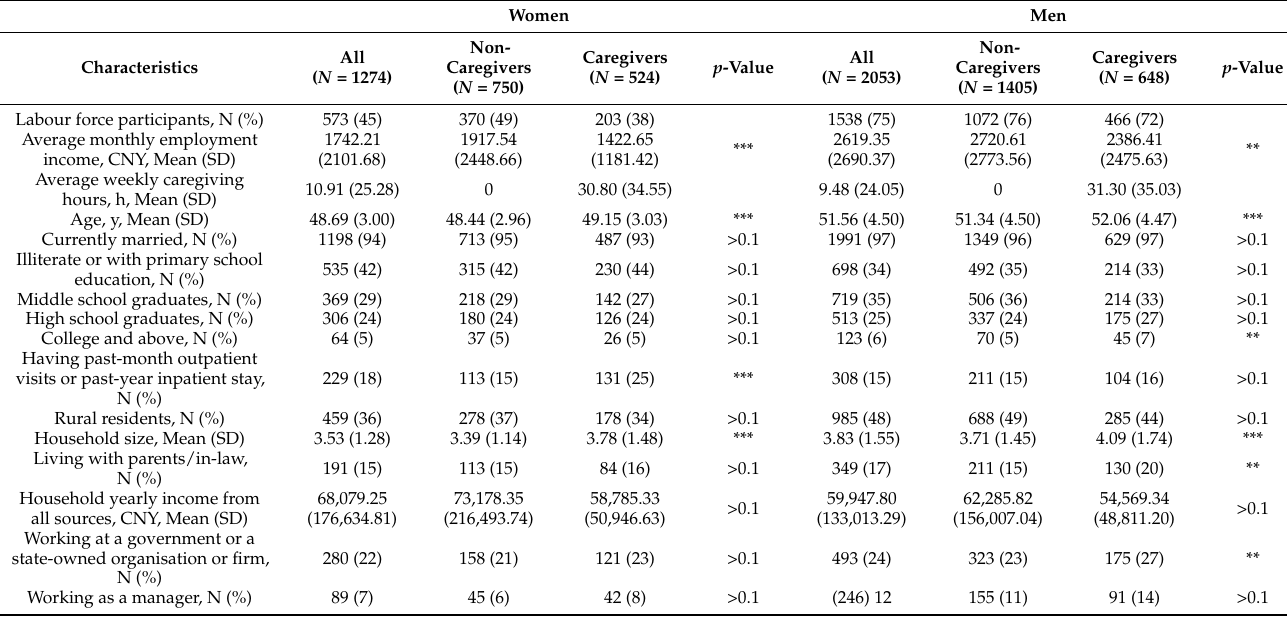
Table 2. Comparing the characteristics of caregivers and non-caregivers among labour force–participating women and men.